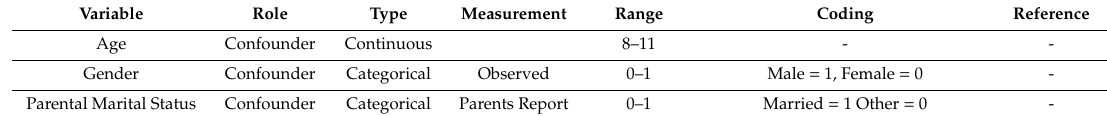
Table 1. Measurements and